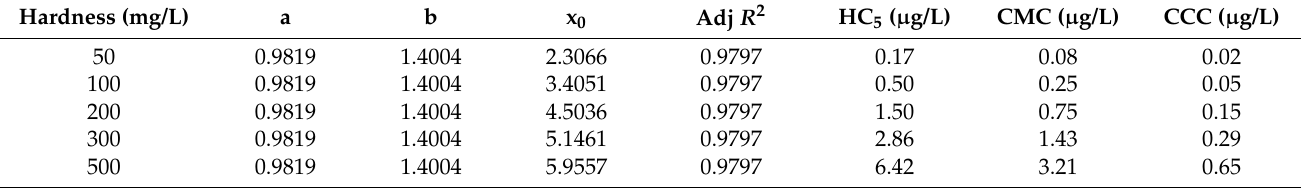
Table 3. The fitting evaluation results of the sigmoid model, and the values of the acute HC 5 , CMC, and CCC for different hardness